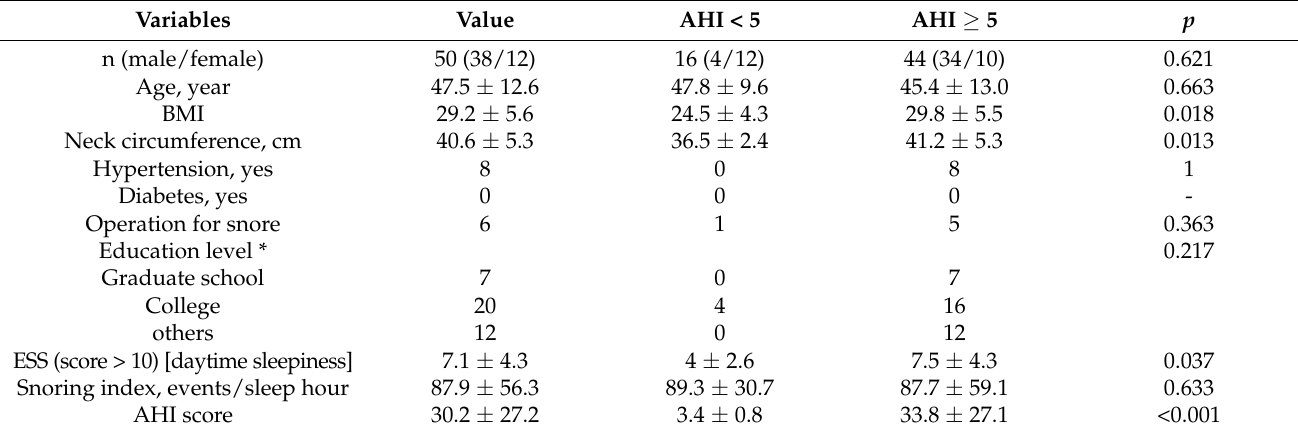
Table 1. Demographic characteristics of participants.